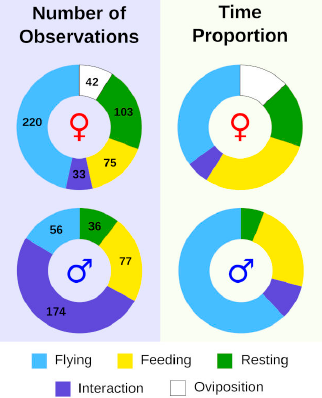
Figure 1. Overview of behavioural patterns of Phengaris teleius reflected by the numbers of observations ( left ) and duration of each type of behaviour ( right ) during the butterfly tracking study. The numbers within the graph represent sample sizes, while symbols denote females ( ♀ ) and males ( ♂ ).